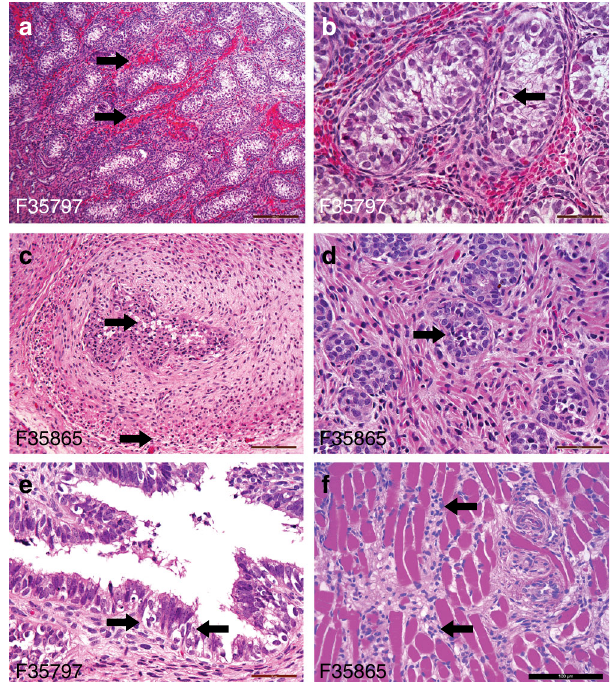
Fig. 8 Histological images of fetal genitourinary tract tissues. At delivery, fetal tissues from testis ( a , b ), seminal vesicle ( c ), prostate ( d ), seminal vesicle ( e ), and pelvic fl oor ( f ) were paraf fi n-embedded, sectioned and stained with hematoxylin and eosin. Shown are representative images. Arrows indicate the presence of the following: a testicular hemorrhage; b testicular apoptotic cell; c seminal vesicle degeneration and apoptotic bodies in both the epithelial and smooth muscle layers; d vacuolar degeneration and apoptotic cells in the prostate; e seminal vesicle vacuolar degeneration and apoptotic bodies; and f lymphocytic in fi ltrates in the skeletal muscle of the pelvic fl oor adjacent to the bladder. Scale bar is 200 µ m ( a , c ), 100 µ m ( f ), and 50 µ m ( b , d , and e